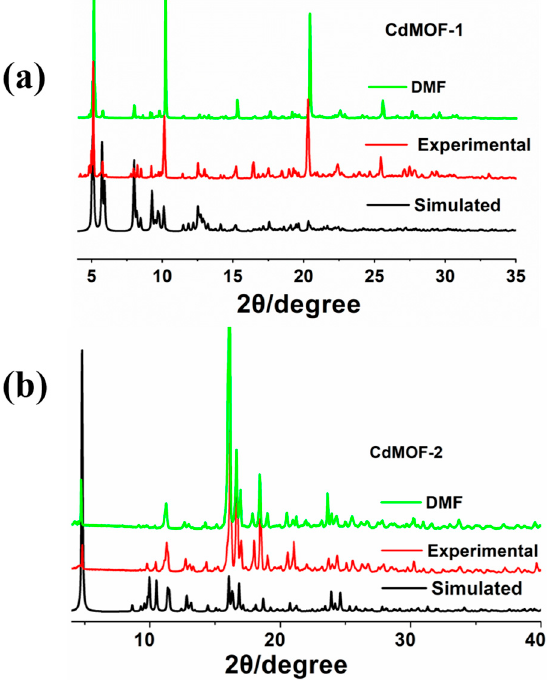
Figure 3. ( a ) Powder X-ray diffraction of CdMOF-1 under different conditions. ( b ) Powder X-ray diffraction of CdMOF-2 under different conditions.